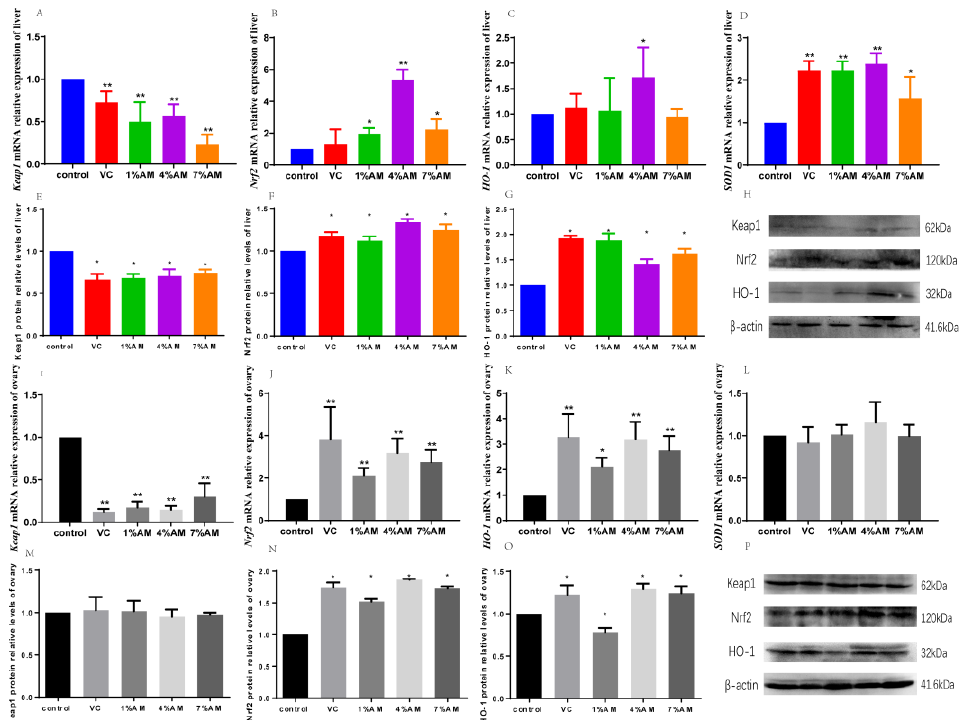
Figure 3. Effects of feed supplemented with AM on Keap1/Nrf2 signaling pathway. Values are shown as mean ± SD ( n = 6). Significant differences compared to control group are designated as ** show very significant difference at p < 0.01, * show significant difference at p < 0.05. Keap1 ( A ), Nrf2 ( B ), HO-1 ( C ) and SOD1 ( D ) gene expressions in liver, Keap1 ( E ), Nrf2 ( F ), HO-1 ( G ) protein expressions in liver, protein gray value in liver ( H ), Keap1 ( I ) , Nrf2 ( J ) , HO-1 ( K ) and SOD1 ( L ) gene expressions in ovary, Keap1 ( M ), Nrf2 ( N ) and HO-1 ( O ) protein expressions in ovary, protein gray value in ovary ( P ). Abbreviations: Keap1, Kelch-like ECH- associated protein l, Nrf2, Nuclear factor-erythroid 2-related factor 2, HO-1, Heme Oxygenase-1, SOD1, Superoxide Dismutase 1.